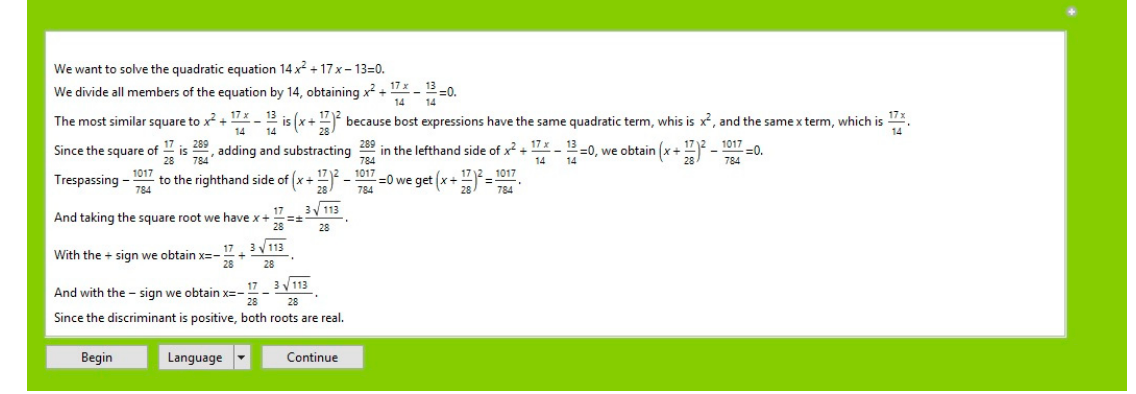
Figure 1. Example of